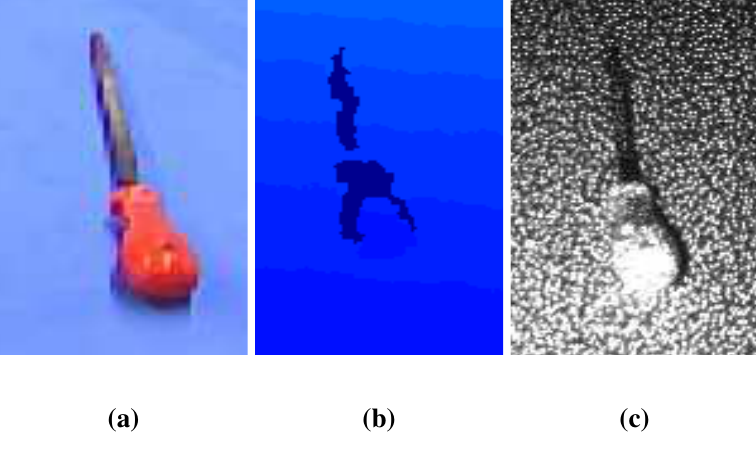
Figure 17. The color, depth and infra-red images obtained by the camera. Using the infra-red speckles, the depth is obtained with a structured light technique. In this case, the object has thin parts that not enough speckles reach, and no depth information can be